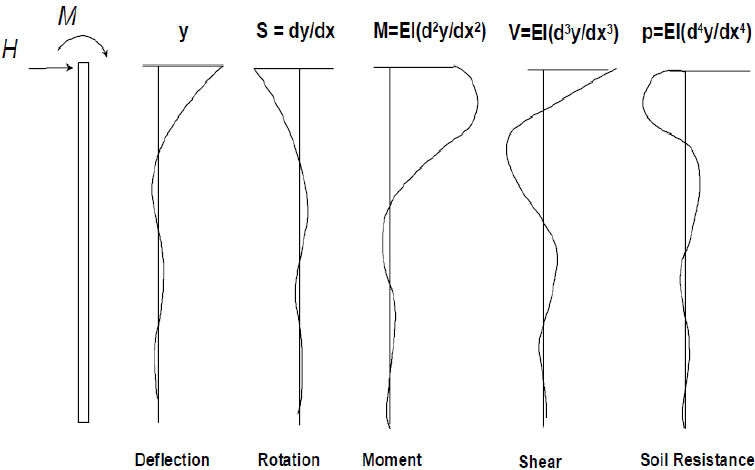
Figure 2. The deflection, rotation, moment, shear force and soil resistance of the pile foundation around the pile.